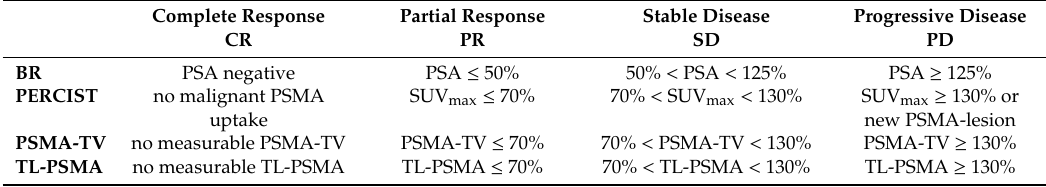
Table 2. Biochemical and PET / CT-derived clinical response criteria applied within our study. BR: biochemical response; PSA: prostate-specific antigen; PSMA: prostate-specific membrane antigen; SUVmax: maximum standardized uptake value. PSA, SUVmax, PSMA-derived tumour volume (PSMA-TV) and total lesion-PSMA (TL-PSMA) represent follow up values as percentage